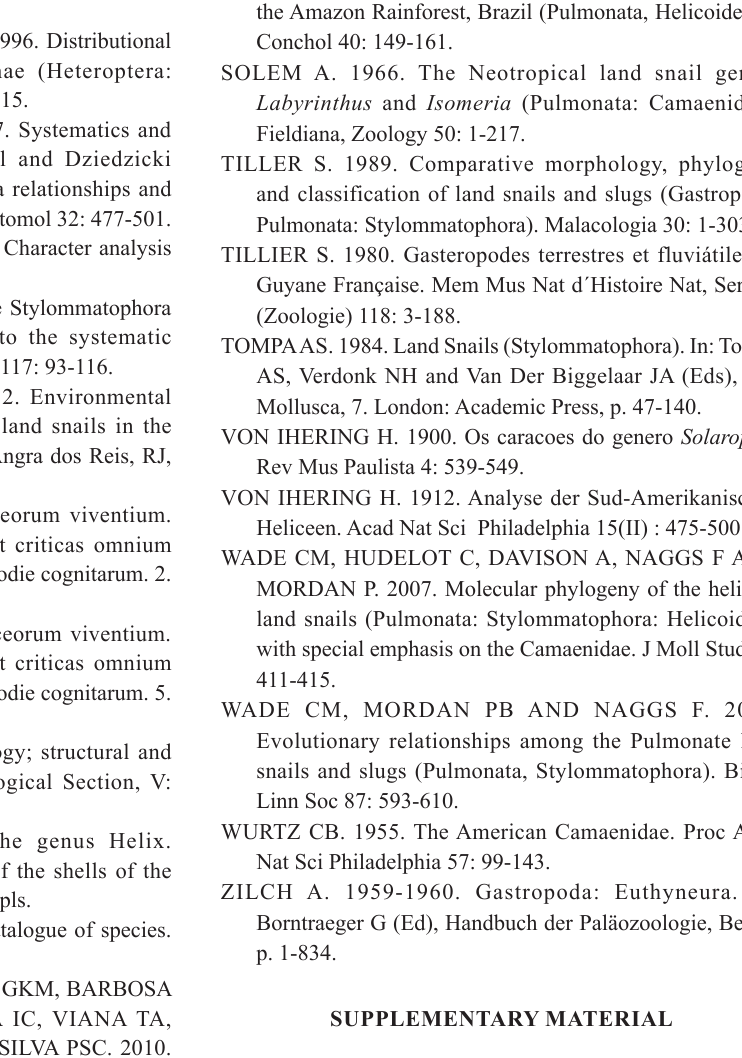
Table SI - List of characters and state characters used in the matrix for cladistic analysis. 0-5 are continuous characters, 6-45 are discrete characters. Table SII - Data matrix for the (1-5) continuous characters, based on shell measurements, (6-46) discrete characters, based on anatomy and 23 taxa, built with WINCLADA and analyzed with TNT in this study. Missing characters are indicated by